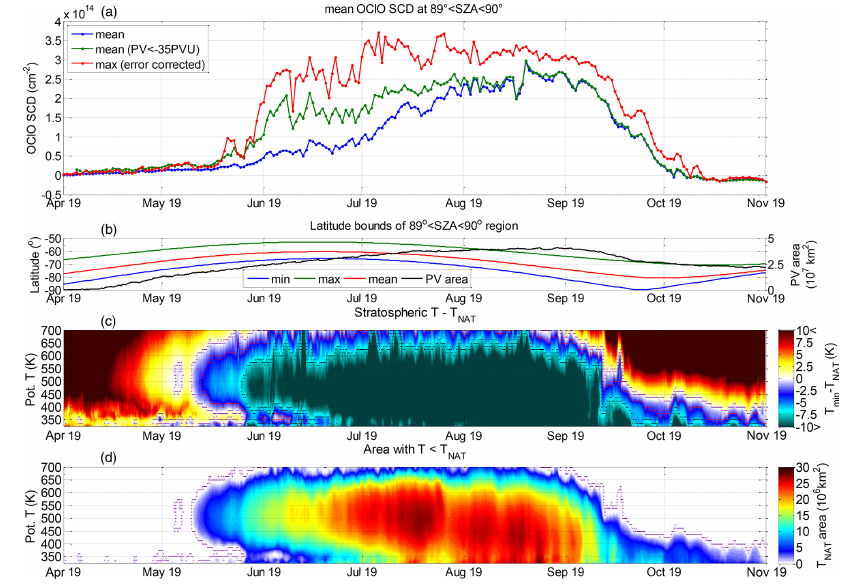
Figure 13. Same as Fig. 1 but for the Antarctic winter 2019.